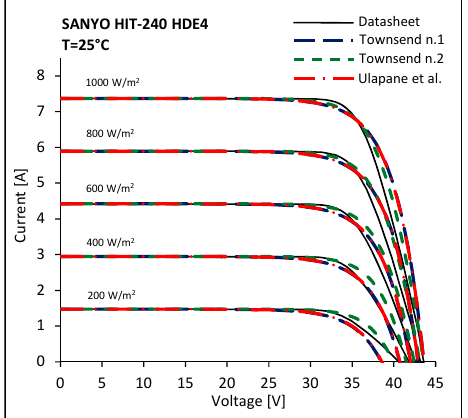
Figure 8. Comparison between the issued I-V characteristics of the Sanyo HIT-240 HDE4 at T = 25 °C and the characteristics calculated by means of the Townsend n.1, the Townsend n.2 and the Ulapane et al. models.